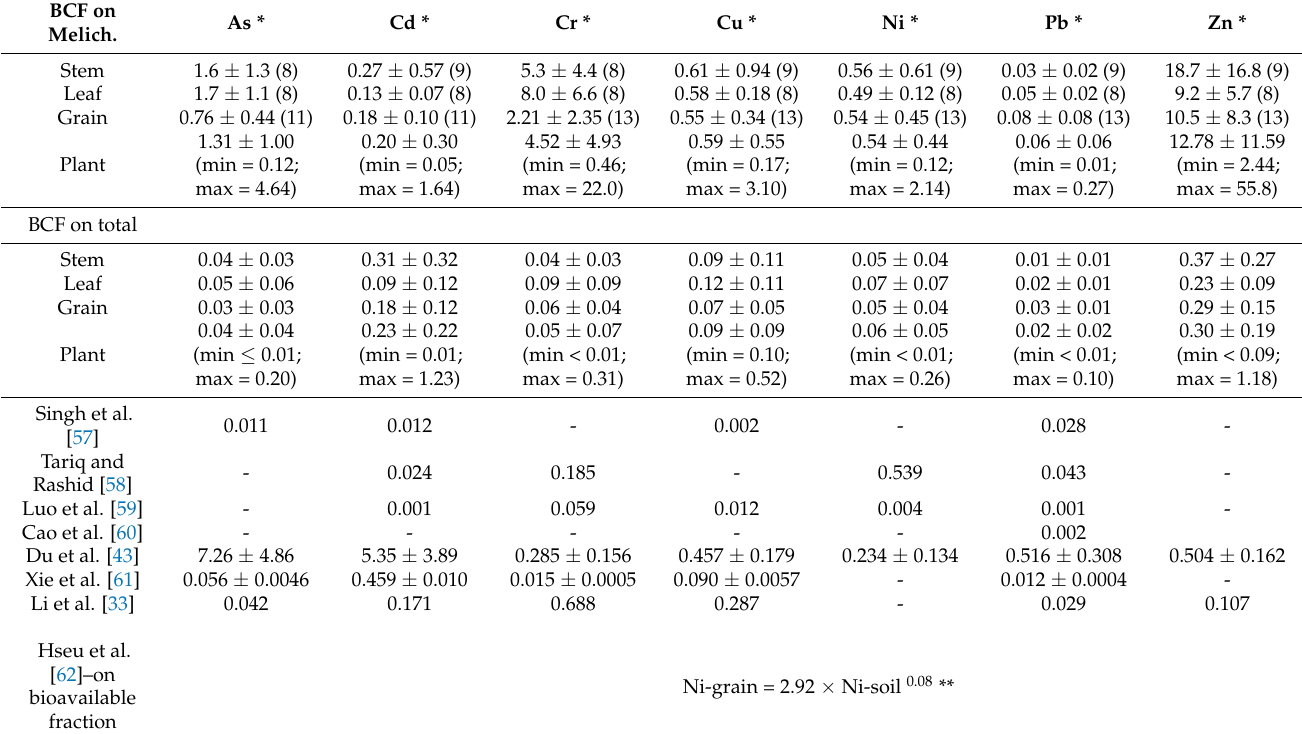
Table 4. Bioconcentration factors (BCF) for the studied metal(oids). Average ± standard deviation (sample size). BCF on